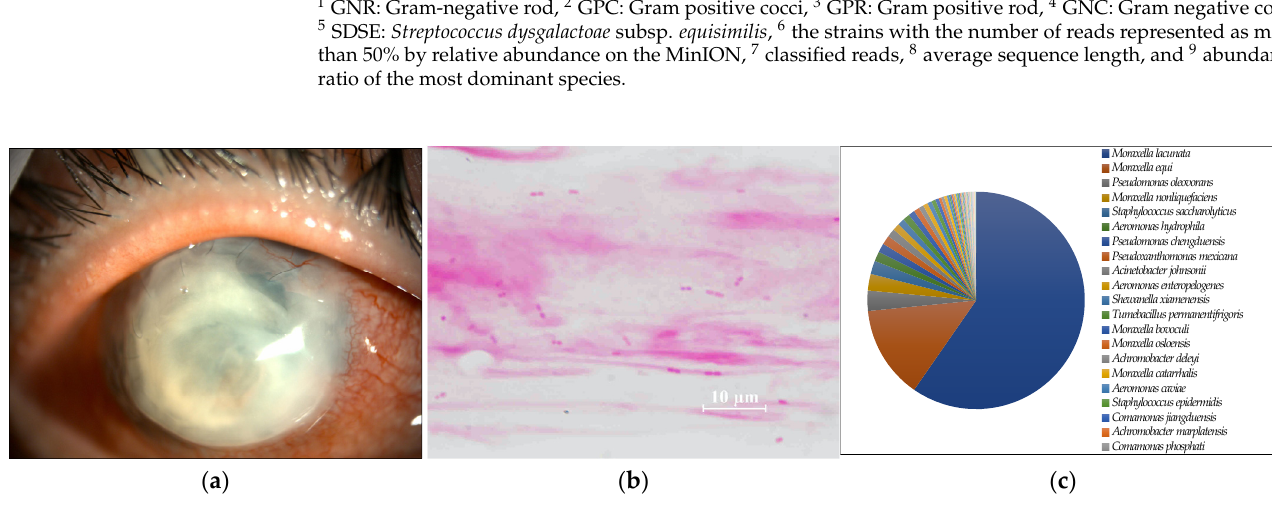
( c ) Figure 3. ( a ) Anterior segment photograph. The entire cornea has pale opacity and hypopyon is obvious. ( b ) Smear microscopy. Elongated Gram-negative rods were detected. ( c ) Nanopore se- quencing results (relative abundance) of Case 3. ( c ) An overwhelming majority of Pseudomonas ae- ruginosa was detected by MinION. ( a ) ( c ) Figure 4. ( a ) Anterior segment photograph. The lower 3/4 of the flap created by former LASIK forms a circular abscess. ( b ) Smear microscopy. Gram-positive chain cocci were detected. ( c ) Nanopore sequencing results (relative abundance) of Case 4. An overwhelming majority of Streptococcus dys- galactoae was detected by MinION.